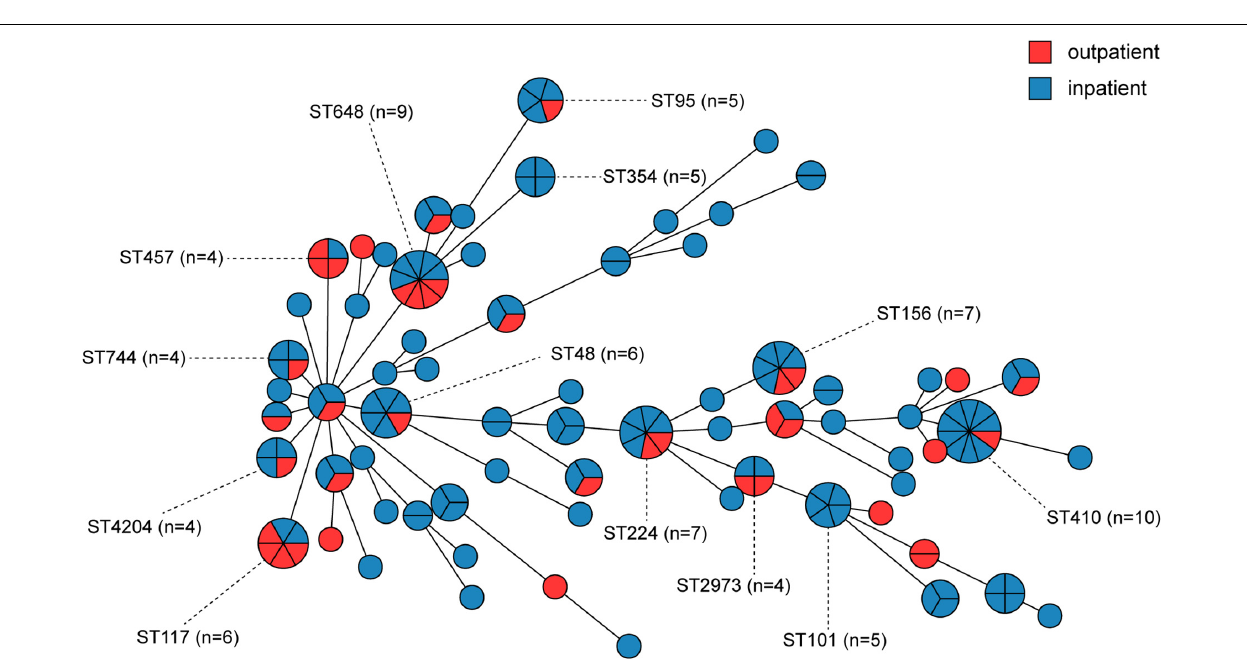
FIGURE 4 | Minimum spanning tree of mcr-1- positive E. coli by MLST type and gene allele from inpatients and outpatients. Each node in the tree represents an ST, and the size of a node is proportional to the number of isolates it represents. The length of the branch is equal to the number of different alleles (calculated using seven MLST genes) between two linked